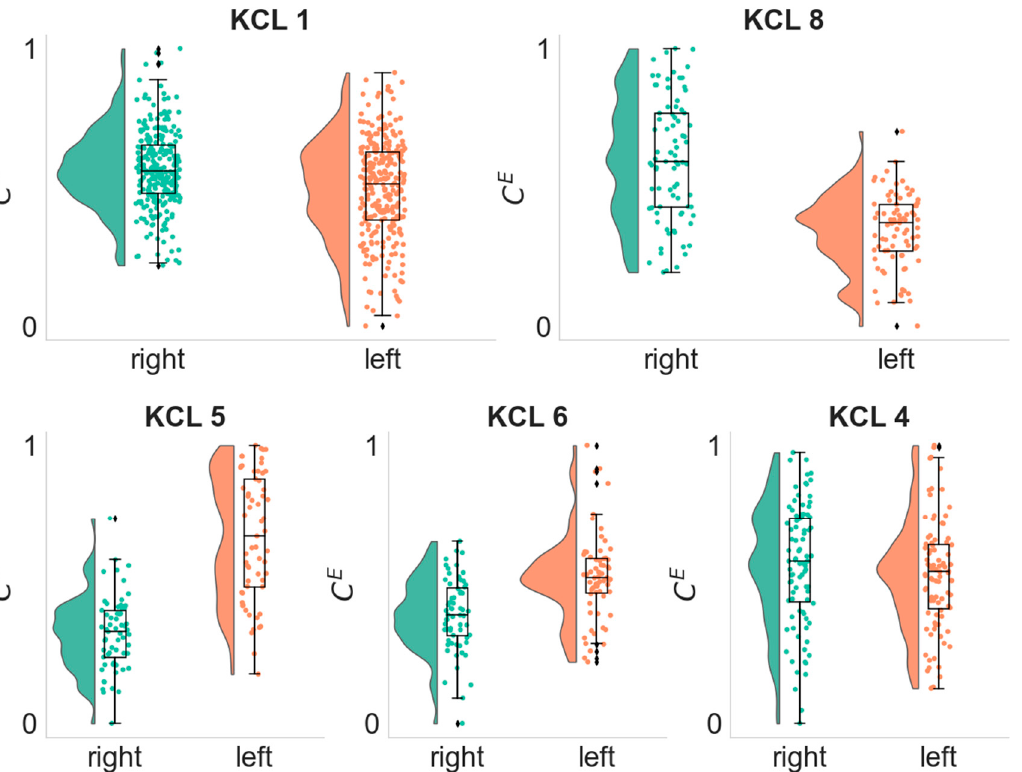
Figure 6. Distributions of the Average Eigenvector Centrality 𝐶 (cid:3006) of each hemisphere in the alpha frequency band. Each dot depicts the C E value of the right (green) or left (orange) hemisphere as computed from a single EEG segment. KCL 1 and KCL 8 participants had the seizure focus on the right hemisphere ( p -values 3.13 × 10 − 6 and 3.54 × , respectively, one-sided Wilcoxon rank-sum test), whilst KCL 5, KCL 6 and KCL 4 had the seizure focus on the left hemisphere ( p -values 1.75 × 10 − 14 , 3.63 × 10 − 7 and 0.9, respectively, one-sided Wilcoxon rank-sum